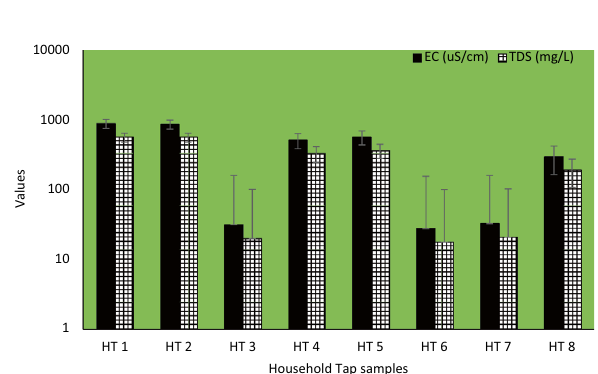
Figure 4. EC and TDS levels for household taps.